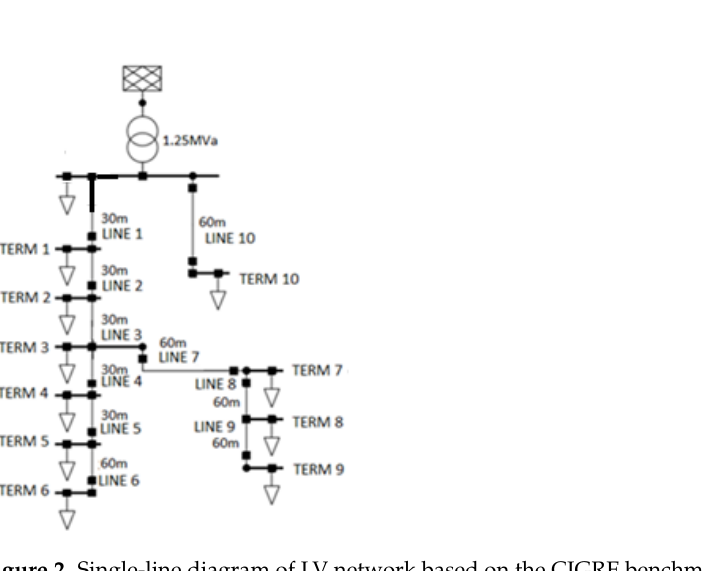
Table 1. EV penetration scenarios for network 1 [19].